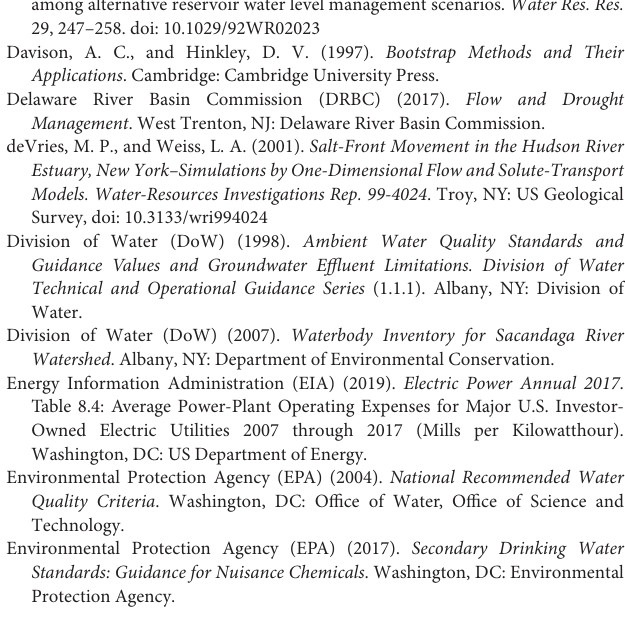
Table 8.4: Average Power-Plant Operating Expenses for Major U.S. Investor- Owned Electric Utilities 2007 through 2017 (Mills per